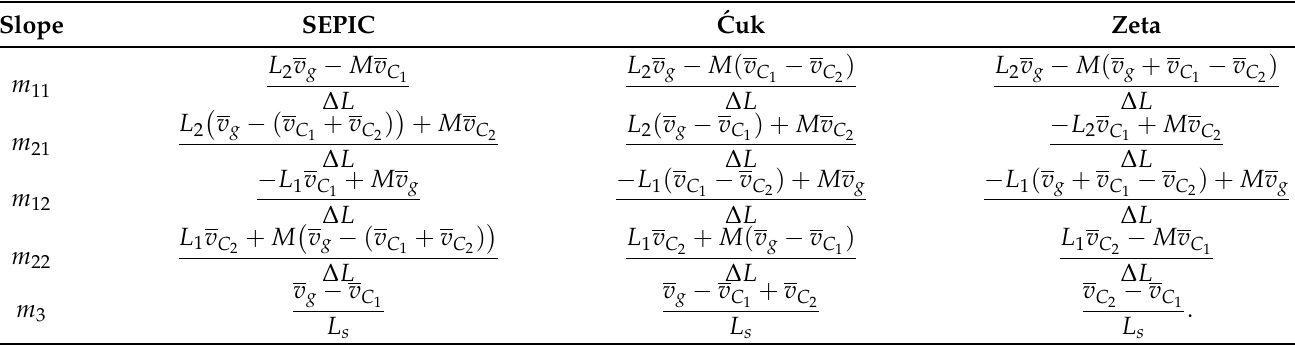
Table 2. Generalized slope of the inductor current waveform in the SEPIC, ´Cuk and Zeta converters. Slope SEPIC ´Cuk Zeta m